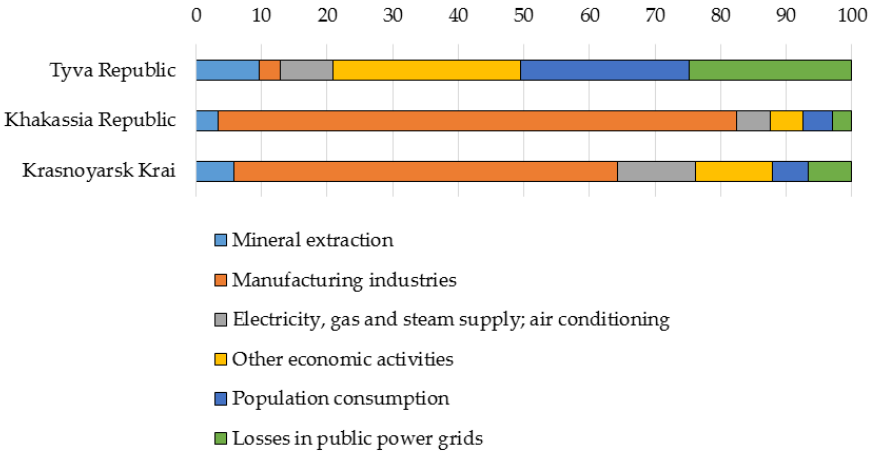
Figure 3. Electricity consumption in Yenisei, Siberia, by economic activity in 2020, %. Source: Rosstat data.